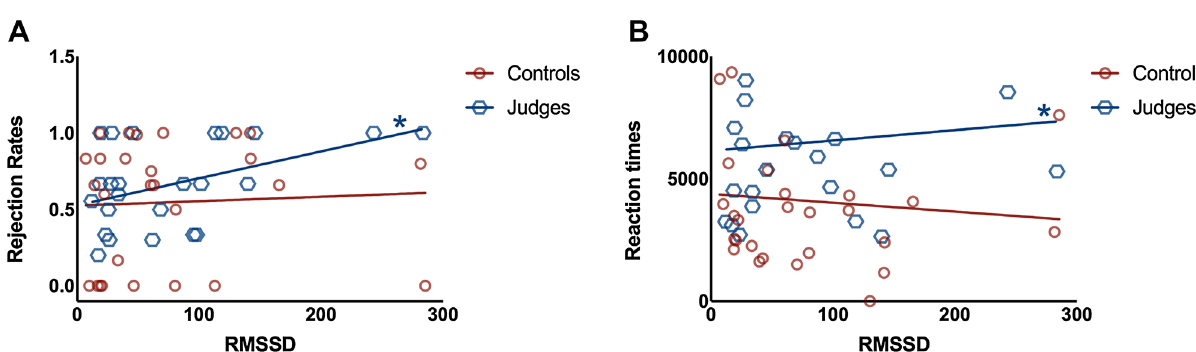
Figure 3. Linear regression models between HRV measurements (RMSSD) and the UG measurements, including the rate of rejections of unfair offers in the comparative rounds, are shown in Panel ( A ); and reaction times in rejected trials are shown in Panel ( B ). An Asterisk reveals significant group comparisons ( p <